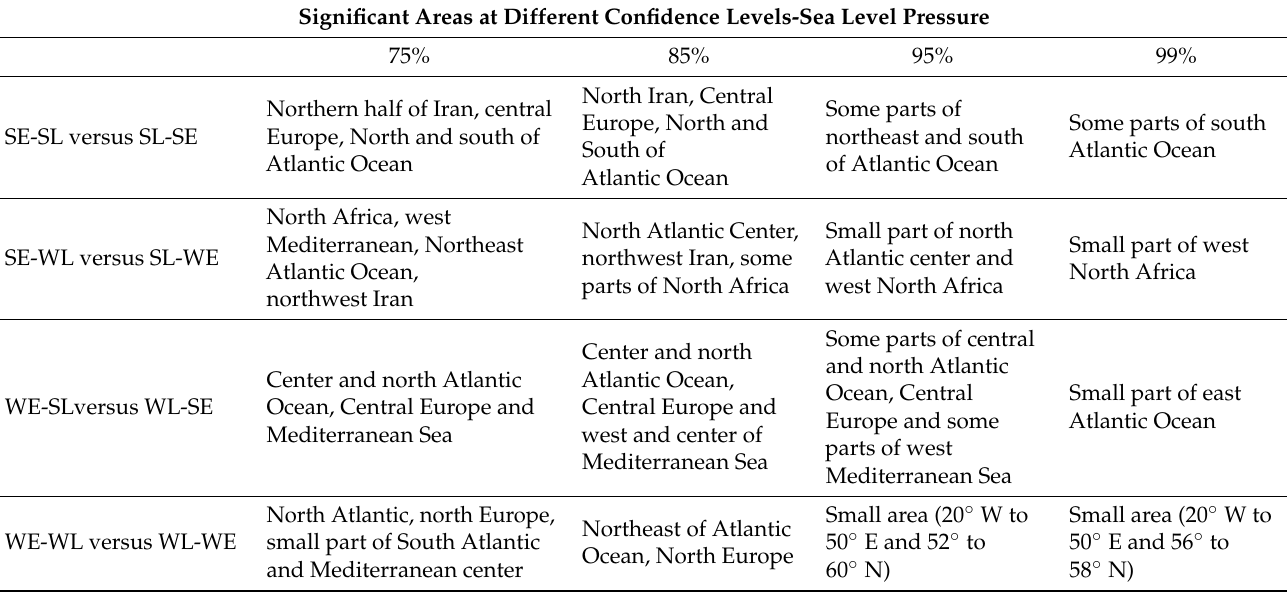
Table 5. Areas of statistically significant differences in SLP at different confidence